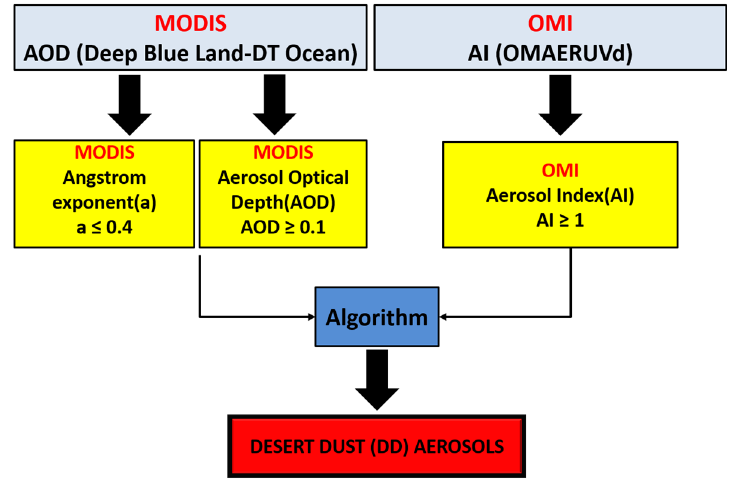
Figure 1. The satellite-based algorithm and methodology applied for the identification of dust aerosols (DA).